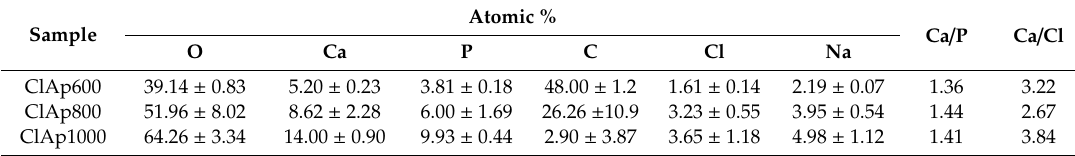
Table 3. EDS analysis of powder